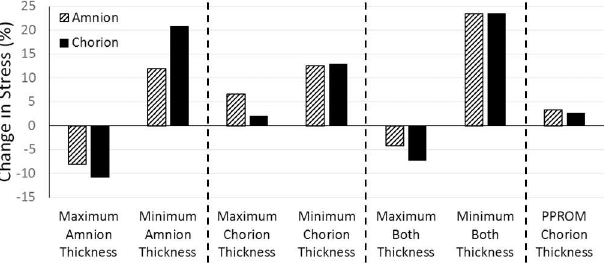
Fig 5. Percentage changesin maximum principalstress basedon stress due to averageamnion and chorion thicknesses in the amnion(902 kPa) and chorion (124 kPa), for maximum and minimumthicknesses of (a) the amnion,(b) the chorion, (c) both membranes simultaneously, and (d) with a thinner chorion due to